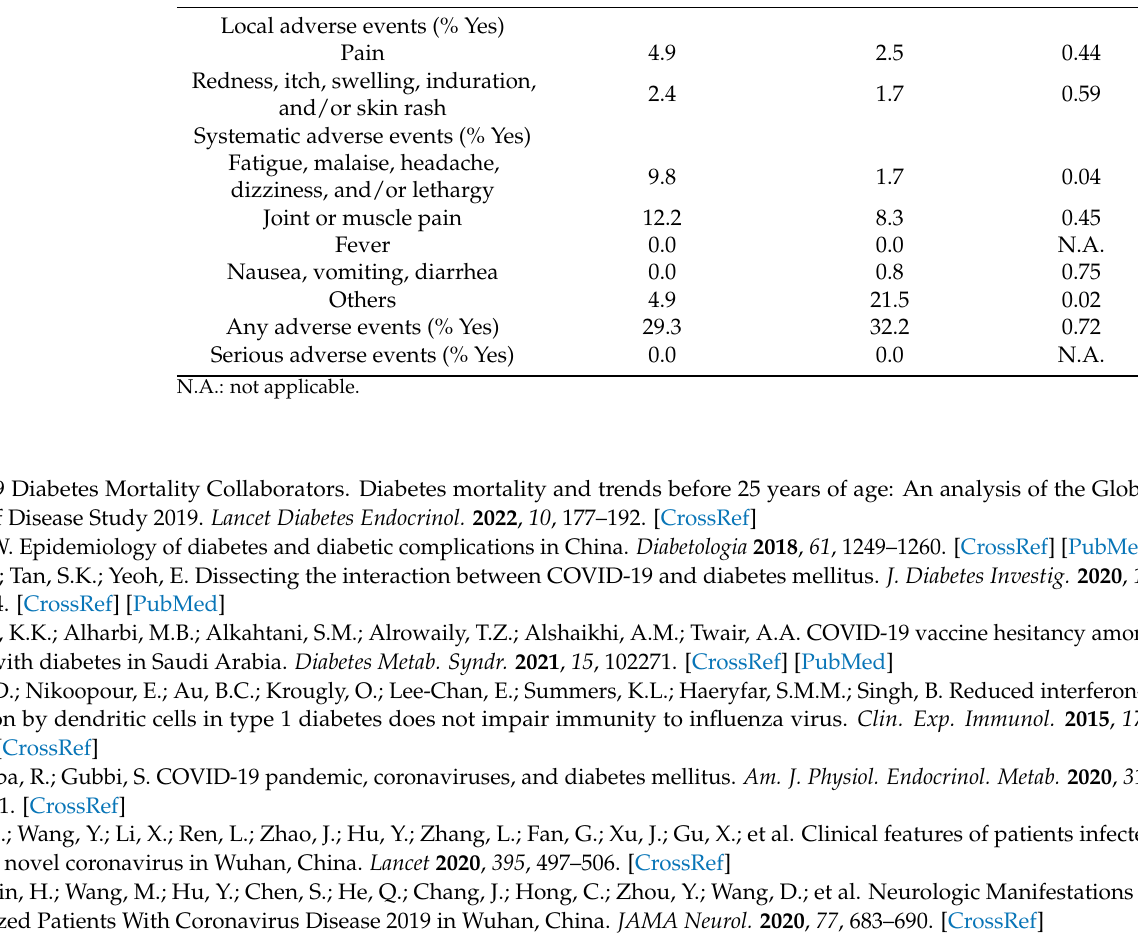
Table A1. Comparing Self-Reported Adverse Events between Participants with and without Chronic Diabetes Mellitus (DM) Complications Who Have Received COVID-19 Vaccination. With Without Self-Reported Adverse Events of p Values Complications Complications COVID-19 Vaccination ( n = 41) ( n = 121) Local adverse events (% Yes) Pain Redness, itch, swelling, induration, and/or skin